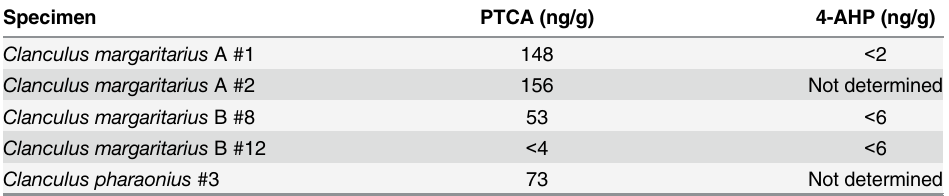
Pyrrole-2,3,5-tricarboxylicacid (PTCA) and 4-amino-3-hydroxyphenylalanine (4-AHP) are speci fi c markers of eumelanin and pheomelanin, respectively. Note C . margaritarius B specimen #12 was a control for the unpigmented nacreous shell layer, as the pigmented layer was removed by Na-EDTA prior to this